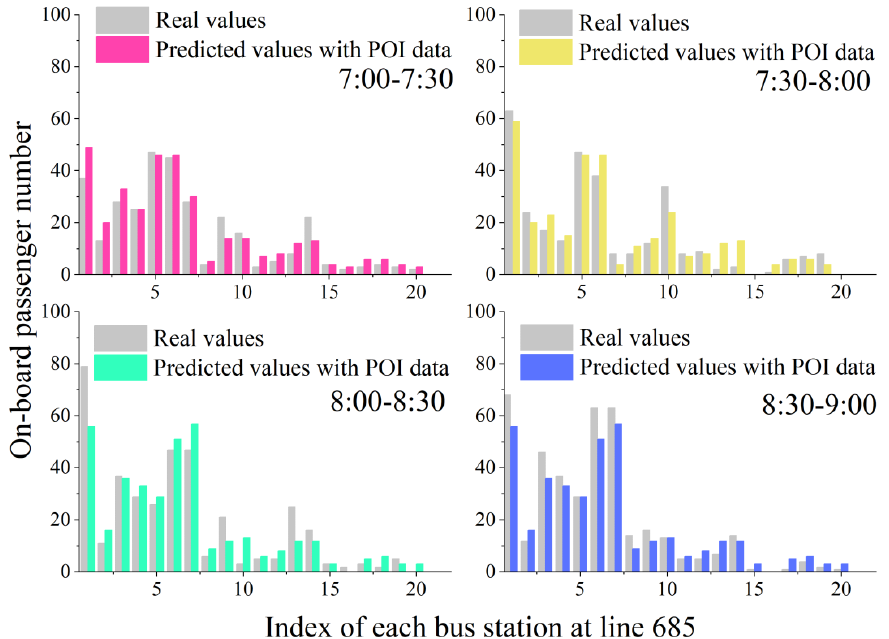
Figure 5. Prediction and true values of on-board passenger numbers for line 685.